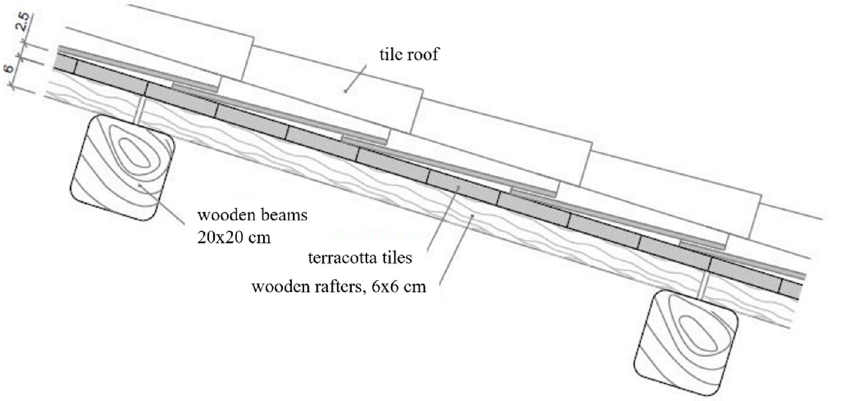
Figure 4. Roof (unit of measure is cm).